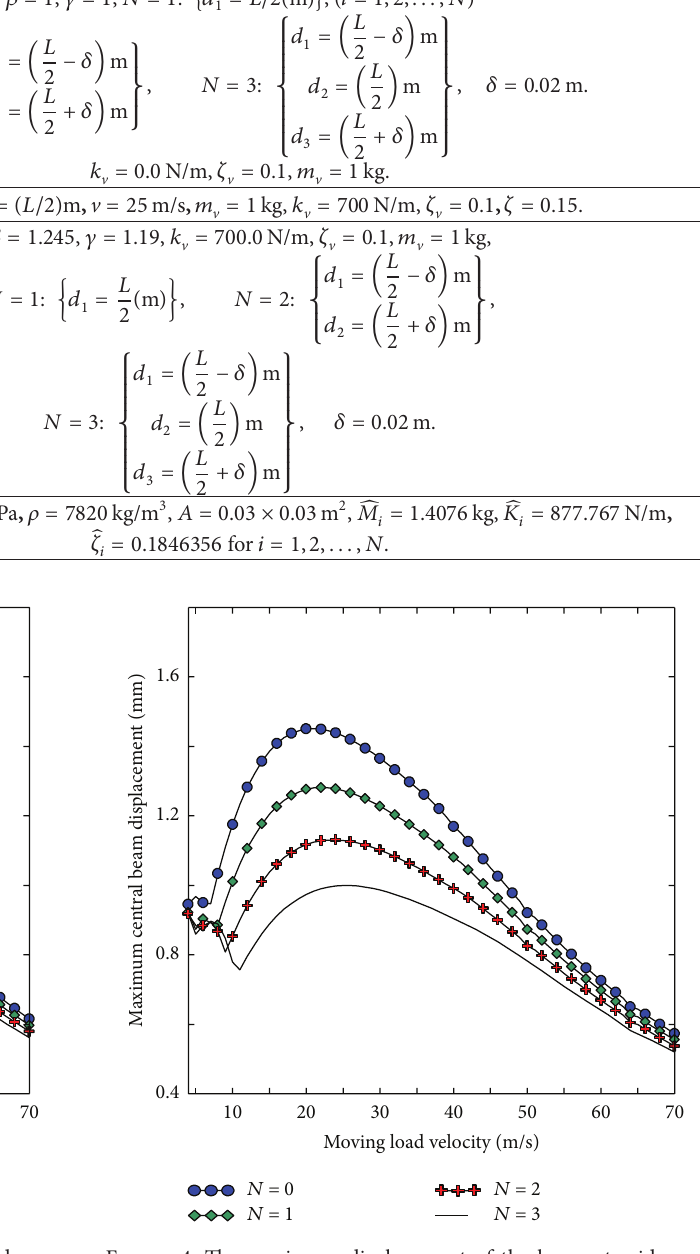
Figure 4: The maximum displacement of the beam at mid-span versus the velocity of the moving load for 𝜁 = 0.075